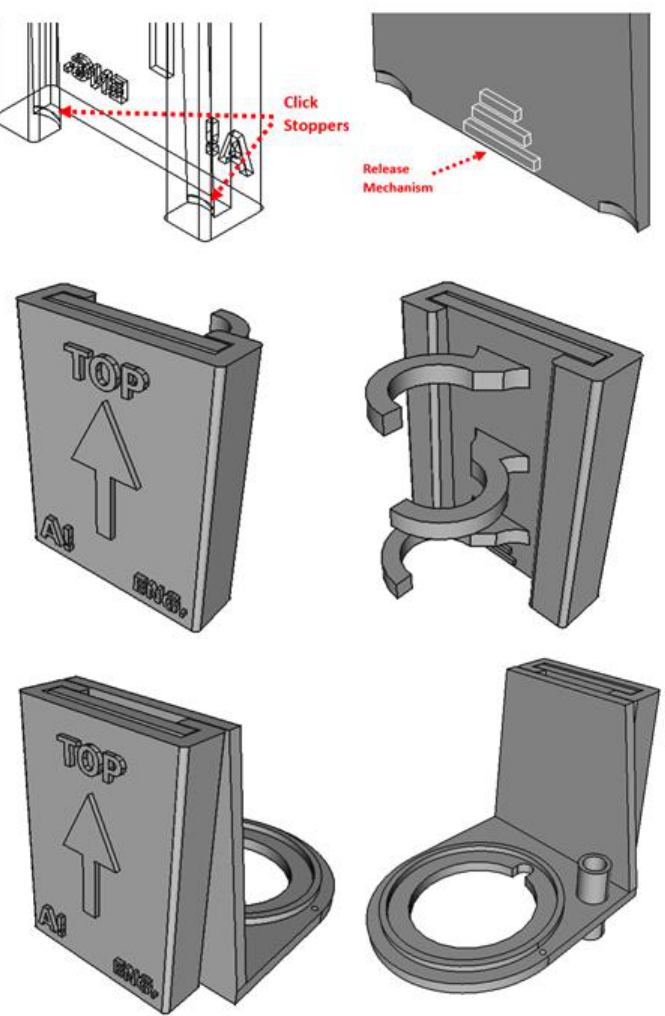
Figure 1. FreeCAD renderings of the fastening mechanism on the sheath ( top left ), releasing mechanism on the slider ( top right ), clip system from the back ( middle left ), clip system with hose holder tool from the front ( middle right ), redesigned clip system for the cyclone sampler from the back ( bottom left ), and redesigned clip system for the cyclone sampler from the front ( bottom right ).